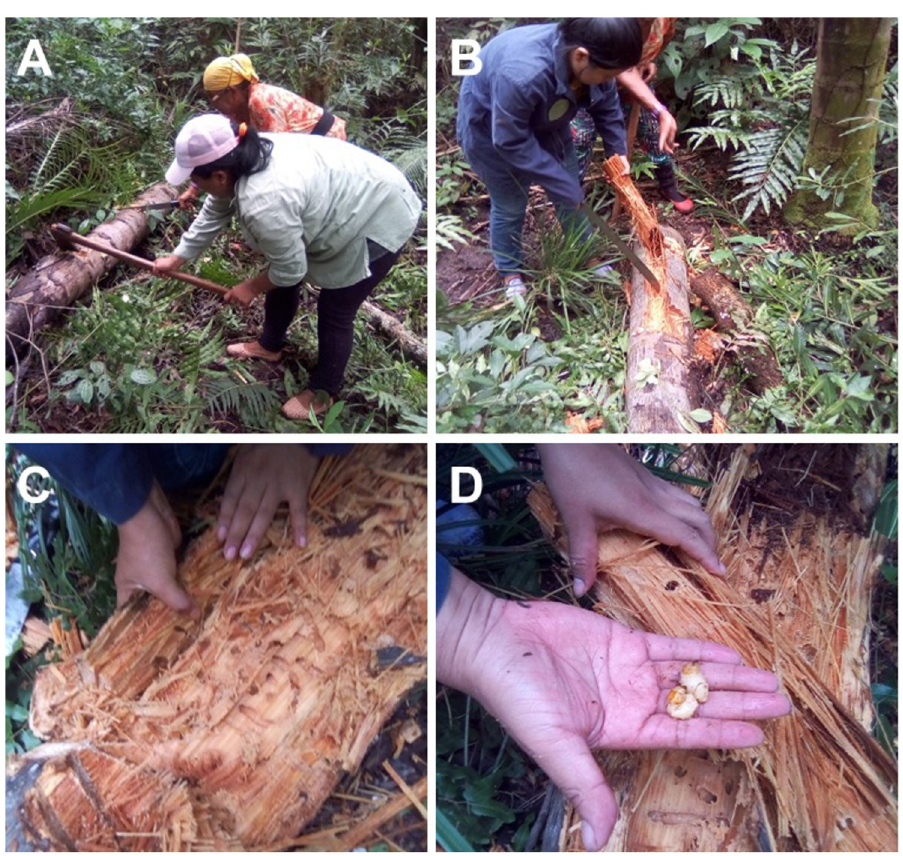
Fig 1. Collection of R . palmarum larvae. (A) Palm trees felled; (B) palm branches being opened; (C) fibers where the larvae develop, and (D) collection of the larvae.